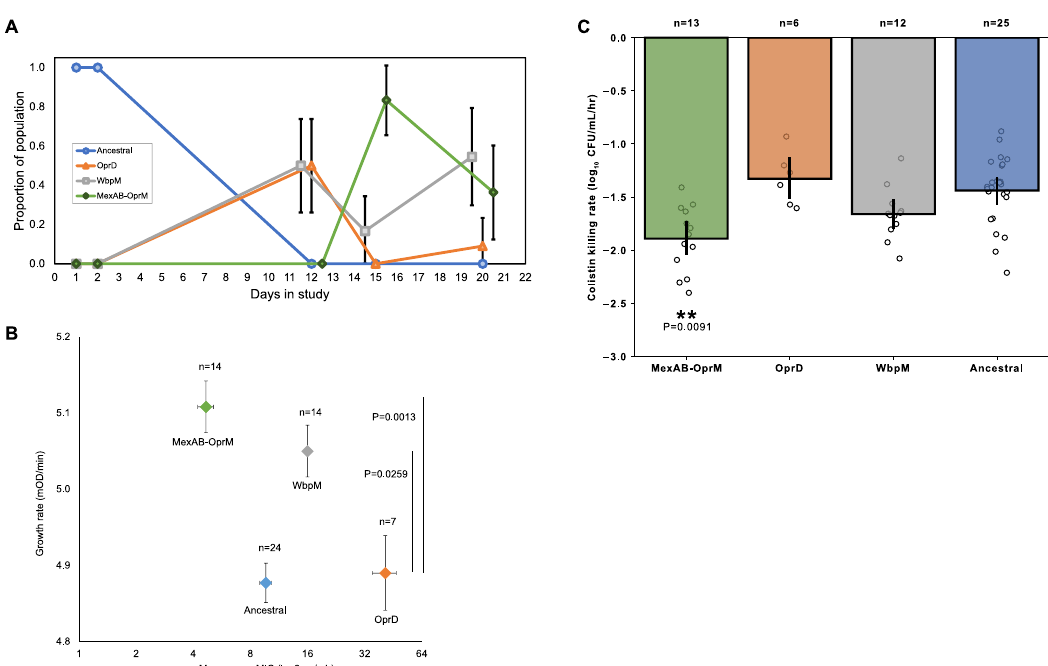
Fig. 3 Evolutionary responses to antibiotic treatment in the lung. A Changes in the genetic composition of the lung population over time. Plotted points show the portion of isolates of the ancestral strain and mutants that evolved in situ ( n = 11 or 12 isolates per time point). Data points were offset for visual clarity and error bars show 90% con fi dence intervals in proportions calculated by the normal approximation to the binomial distribution. B Meropenem resistance and fi tness of respiratory isolates (mean + / − s.e.m; n > 5 isolates per group). Fitness was measured as log-phase growth rate in culture medium lacking antibiotics (10 replicates per isolate). WbpM and MexAB-OprM mutants had high fi tness relative to OprD mutants, as determined by a two-tailed Dunnett ’ s test treating oprD as the control group. C Colistin tolerance, as measured by the rate of cell killing at 2 mg/L colistin (mean + / − s.e. m; n > 5 isolates per group). Altered colistin tolerance was only found in MexAB-OprM mutants, as determined by a two-tailed Dunnett ’ s test treating the ancestral strain as a control group ( P = 0.0091). Source data are provided as a Source Data fi